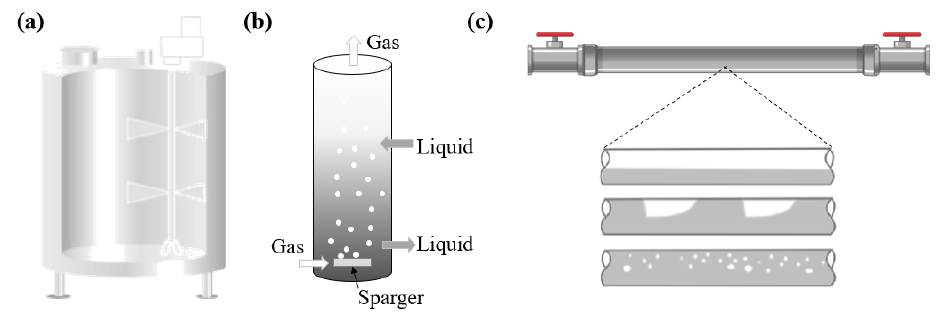
Figure 2. Schemes of ( a ) mixing reactor, ( b ) bubble column reactor, and ( c ) two-phase flow pipe. Adapted from